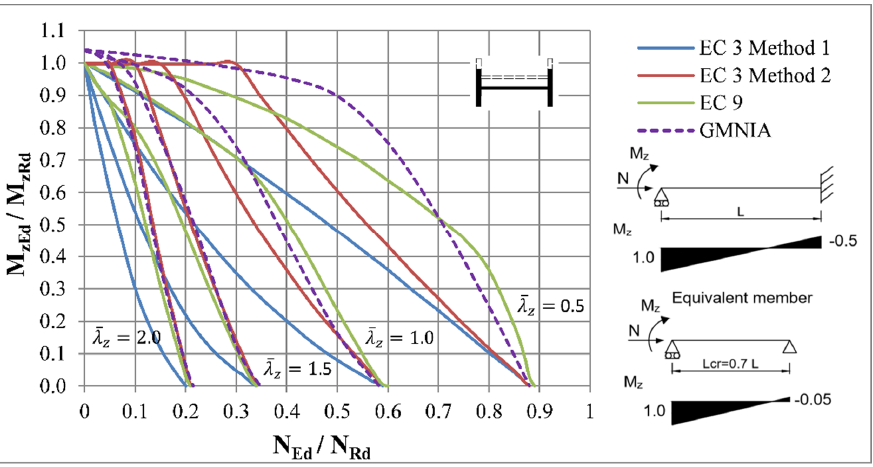
Figure 26. Interaction curves for weak axis flexural buckling of beam-columns with IPE 100 cross-section.